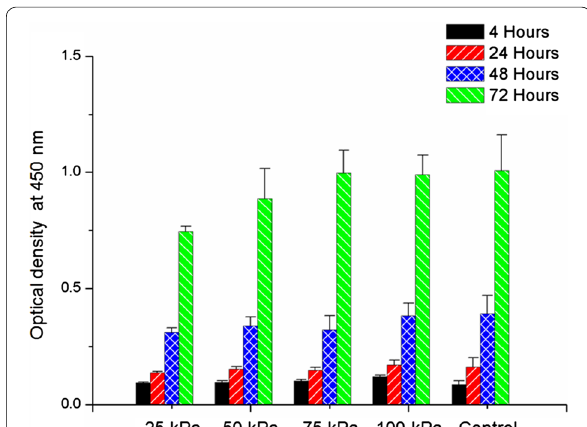
Fig. 6 Cell proliferation result as a function of time in culture after dispensing at different positive pressures. The graph demonstrates that the cell proliferation rate is similar for various positive pressures ( P <